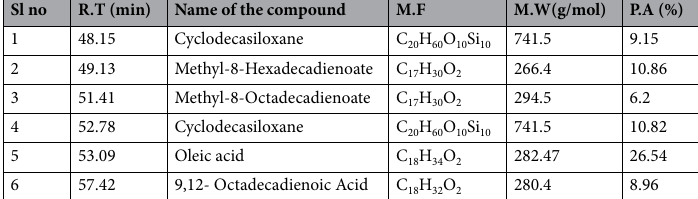
Table 11. Relative percentage of fatty acids in Neelamari ( Indigofera Tinctoria